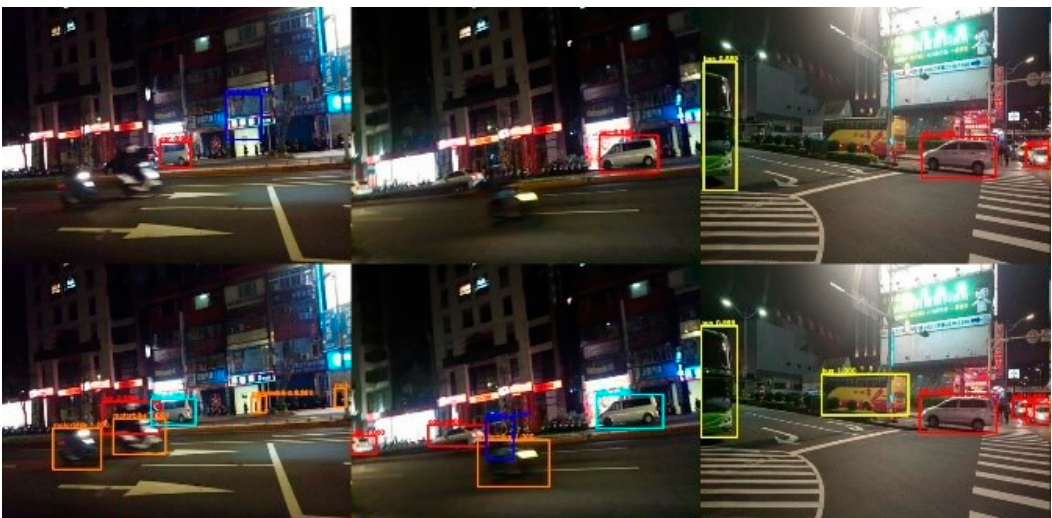
Figure 20. Outputs from two variants of the Faster R-CNN [5] with ResNet101 [2]. Upper row: Ordinary model trained with PASCAL VOC 2007 [6]. Lower row: Proposed system trained with our nighttime data.